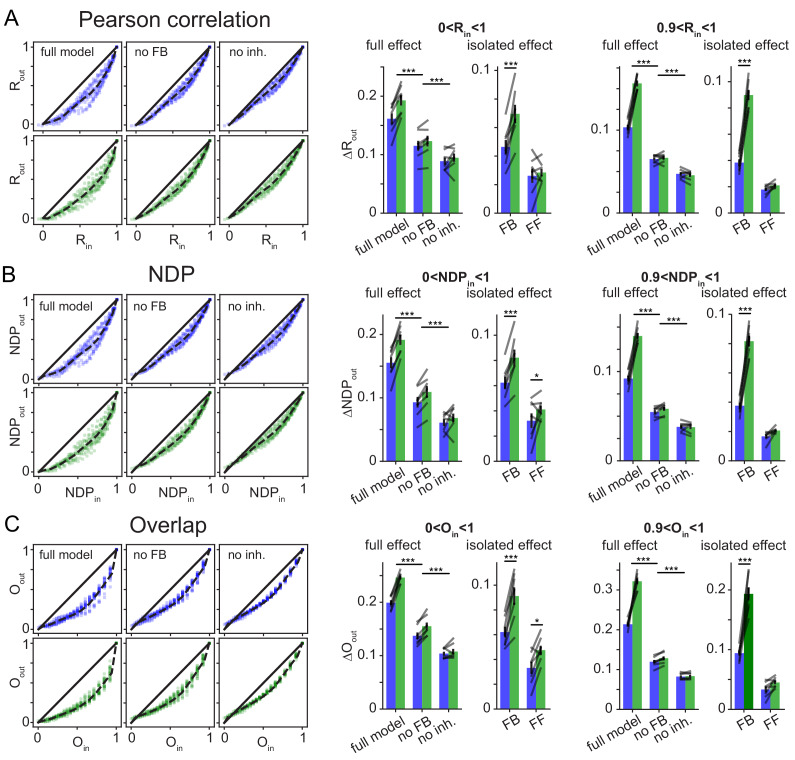
Robustness over different Similarity Metrics.To test if the main finding of frequency dependent pattern separation, particularly for highly similar inputs, depended on the similarity metric used, the original data was reanalyzed with two alternative similarity metrics. As in the main figures data points in bar graphs represent the seven independent network seeds. For each network (seed), we ran sets of patterns for the full model, a network without feedback inhibition (no FB) and a model with no inhibition (no inh.). (A) Pearson’s correlation coefficient R (as in Figure 6) left: exemplary scatterplots of pattern separation effects. right: bargraphs of the mean pattern separation effect over the full input similarity range (0 < Rin1) or only highly similar input patterns (0.9 < Rin < 1). Full effects measure the mean pattern separation effect for each network condition: full model, no feedback (no FB) and no inhibition (no inh.). Isolated effects measure the pattern separation contribution of individual circuit motifs: feedback inhibition (FB) and feedforward inhibition (FF). (B) Same as (A) but using normalized dot product (NDP) as similarity metric for input and output comparisons. (C) Same as (A) but using population overlap as similarity metric. Overlap is defined as the number of cells active in both patterns (logical and) divided by the number of cells active in either pattern (logical or). The full effects were tested with 2 × 3 ANOVAs followed by Sidak’s posttests for differences between conditions. Isolated effects were tested with 2 × 2 ANOVAs followed by Tukey posttests for differences between frequencies. Asterisks indicate significance in posttests given significant overall effects (*p<0.05,**p<0.01,***p<0.001).